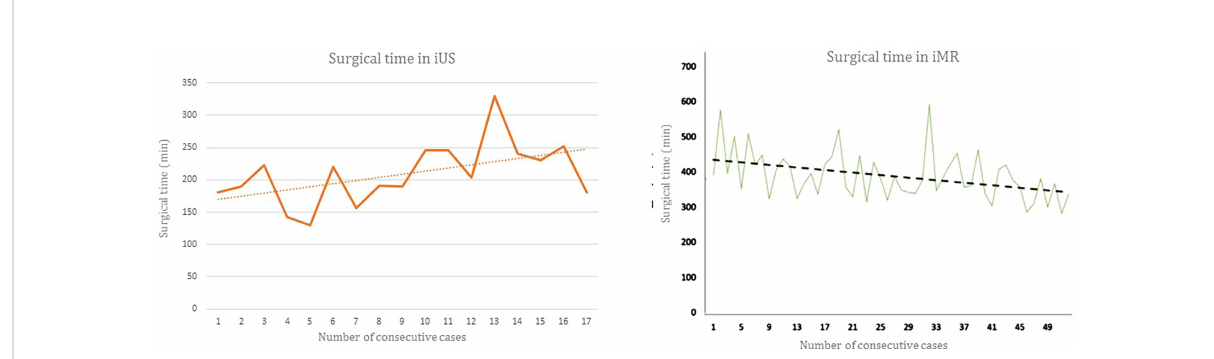
FIGURE 1 Surgical time per patient according to the intraoperative imaging device. The graphics illustrate the sequential evolution of surgical times required for each patient. The superimposed line demonstrates the trend of intraoperative duration as the experience increases with each imaging technology. Left , intraoperative ultrasound (iUS) and Right , intraoperative magnetic resonance (iMR). Reprinted with permission of Garc ı ́ a-Garc ı ́ a et al., 2020 (13).